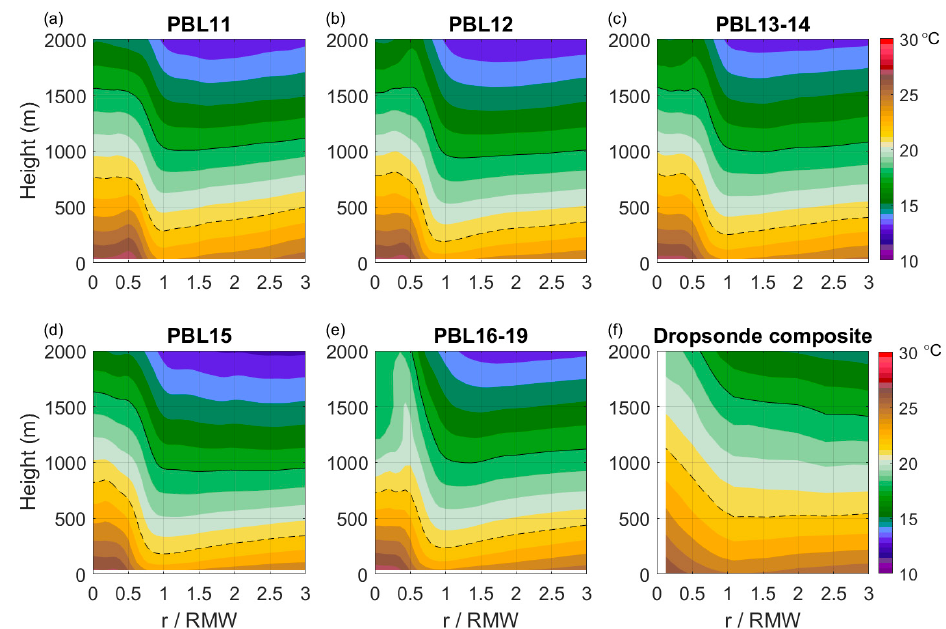
Figure 9. Normalized radius-height plot of azimuthally averaged temperature ( < T > ) over t = 84–108 h in the idealized HWRF simulations with ( a ) PBL11, ( b ) PBL12, ( c ) PBL13–14, ( d ) PBL15, and ( e ) PBL16–19 schemes. The dropsonde composite of ( < T > ) is shown in ( f ). The black solid and dashed lines are the 18 ◦ C and 22 ◦ C contours, respectively. RMW is the radius of the maximum wind speed.